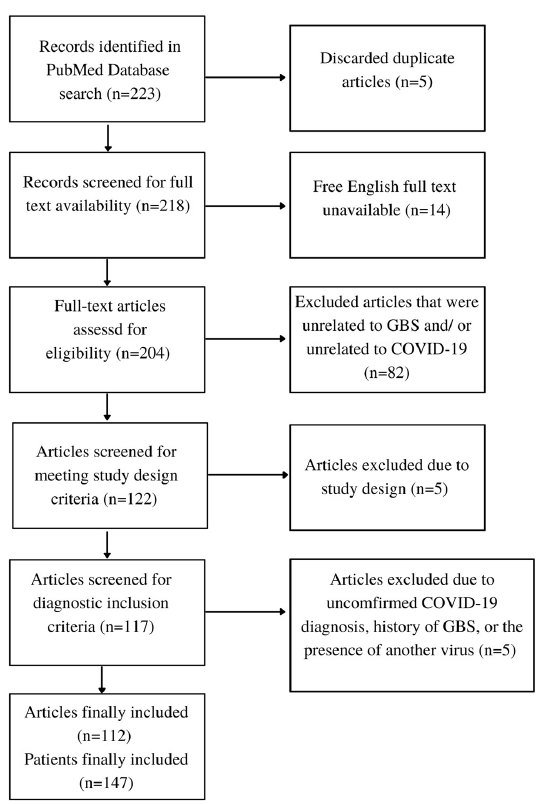
Figure A1. Article exclusion flow chart (PRISMA).